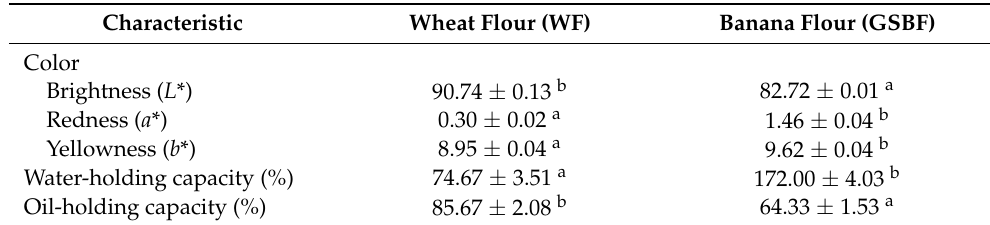
Table 3. Color, water-holding capacity and oil-holding capacity of wheat flour (WF) and green Saba banana flour